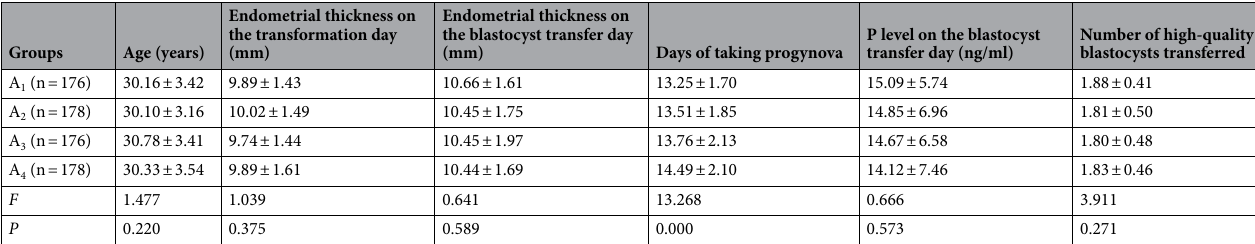
Table 1. Comparisons of clinical characteristics among groups divided by serum estrogen levels on the endometrium transformation day.